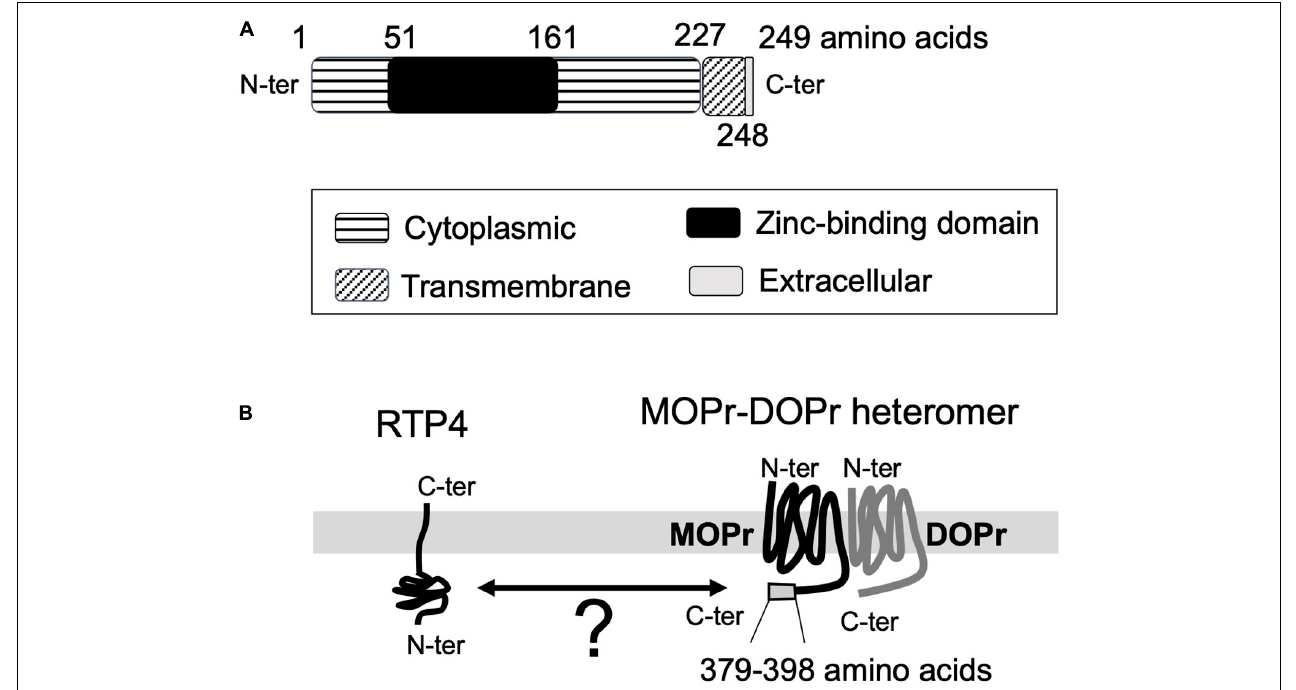
FIGURE 1 | The topological information for RTP4 (A) and the schematic interaction between RTP4 and MOPr-DOPr heteromers (B) . The data was obtained via UniProt data base (uniprot.org). RTP4 (249 amino acids) has a single predicted transmembrane domain (228th to 248th amino acids) located near the C-terminal end. It is considered that the N-terminal end is intracellular (1st to 227th amino acids) and the C-terminal end (249th amino acid) is extracellular, with no signal peptide (UniProt,https://www.uniprot.org/uniprot/Q9ER80) (A) . Decaillot et al. (2008) have suggested that the interaction between RTP4 and MOPr-DOPr heteromer occurs in the cytoplasmic region since the region within the MOPr cytoplasmic C-terminal 29 amino acid residues (i.e., 370–398 aa) was necessary for interaction with RTP4 (B)